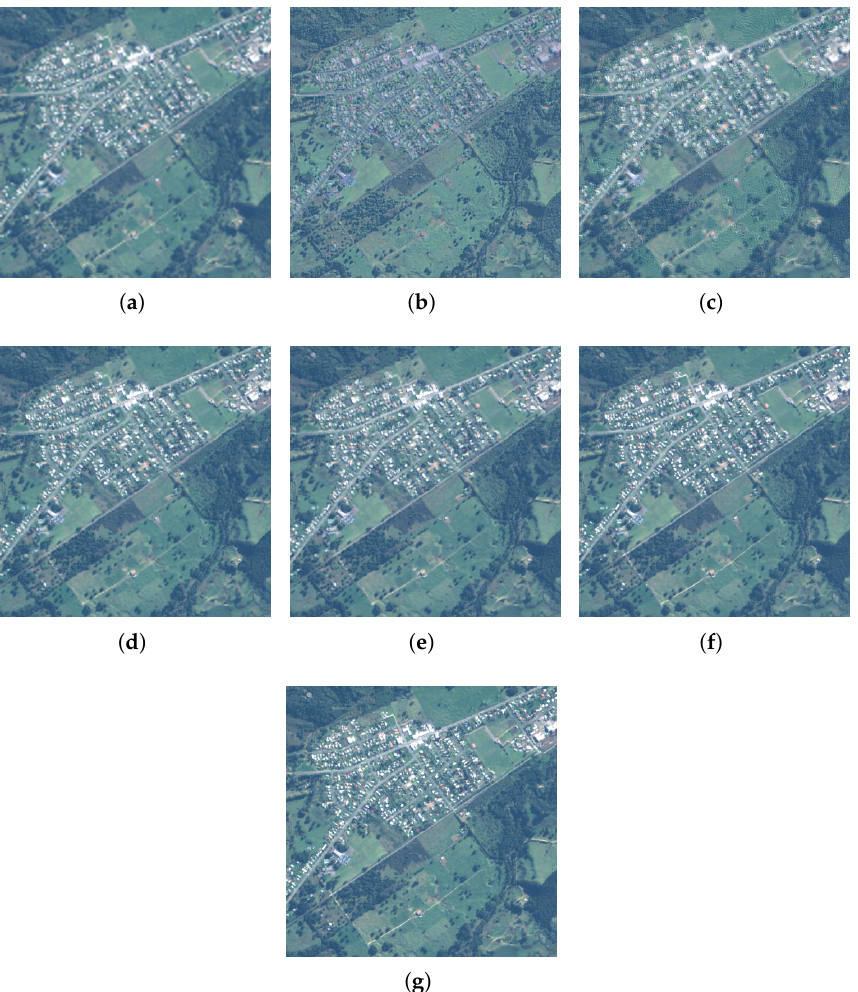
Figure 8. QuickBird original images and Pan-sharpened images by different methods. ( a ) Low-resolution MS; ( b ) AIHS; ( c ) ATWT; ( d ) PNN; ( e ) MSDCNN; ( f ) the proposed method; ( g ) ground